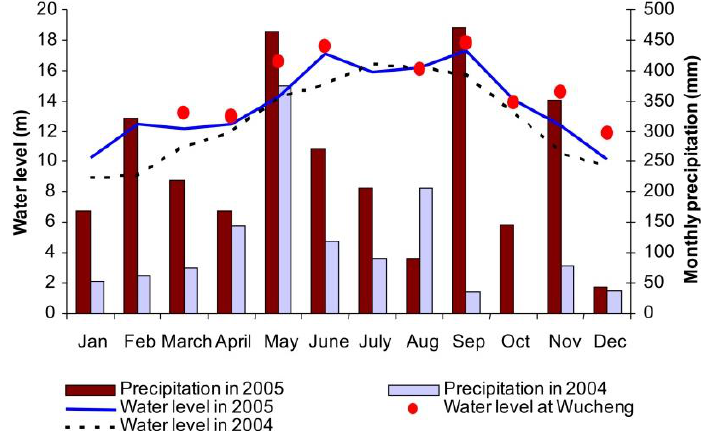
Figure 2. The cumulative monthly precipitation and average water level of Poyang Lake collected in 2004 and 2005 at Duchang hydrology station and the water level data of Xiushui River collected at Wucheng hydrology station on the dates when ENVISAT/ASAR data were acquired in